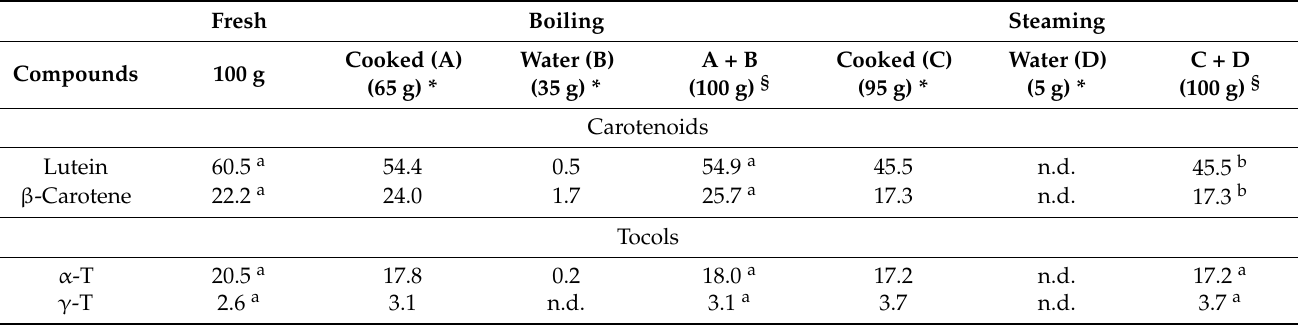
Table 4. Contents of the main carotenoids and tocols in fresh vegetables (mg/100 g d.m.), in cooked samples (mg/g d.m.) and in cooking water (mg/g d.m.) of S. asper .